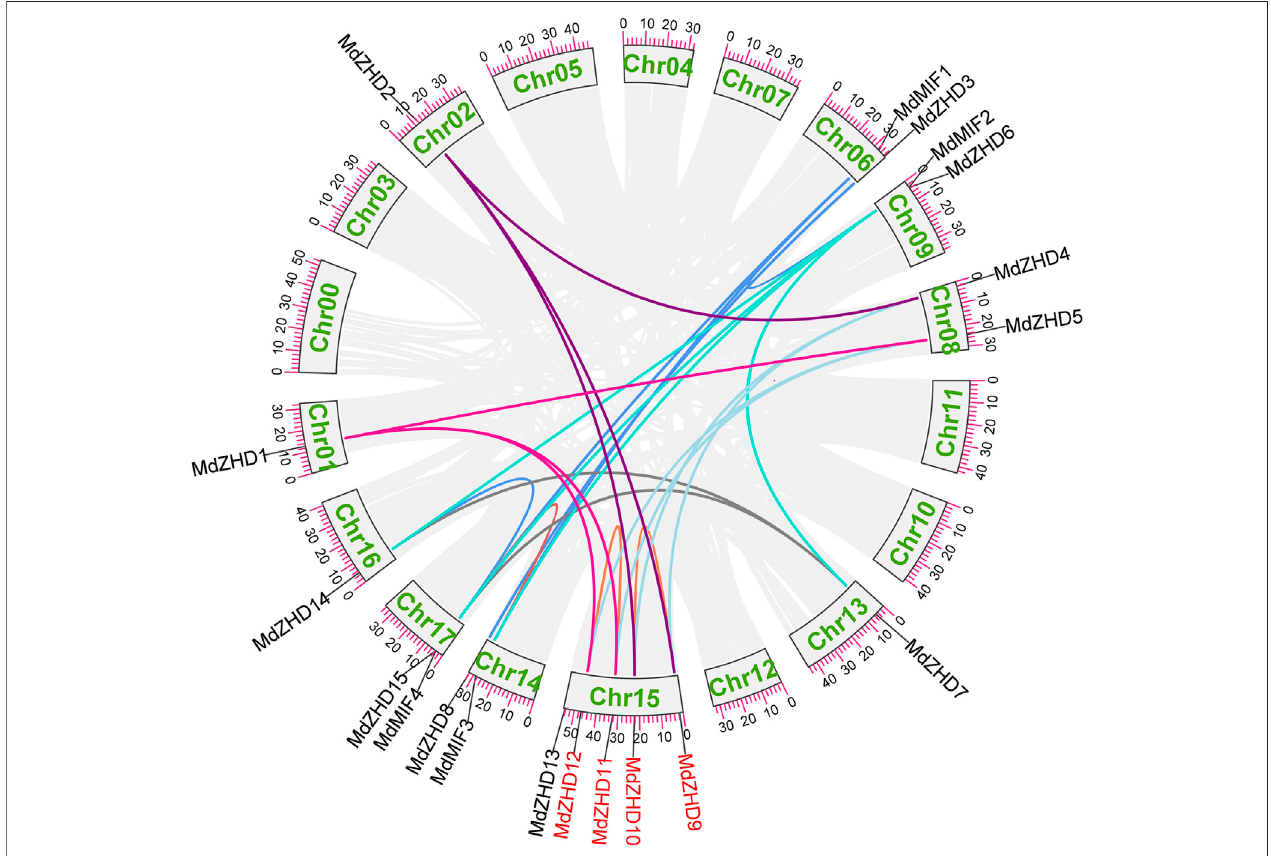
FIGURE4| Homologousrelationshipsandgenereplicationsofthe ZF-HD genesinapple.Thedifferentcoloredlinesindicatethesegmentalduplicatedgenes,while the red gene names highlight the tandem duplicated genes.